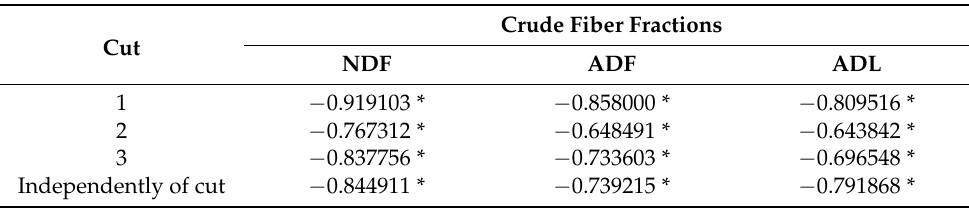
Table 6. Correlation coefficient between dry matter digestibility of Italian ryegrass and the content of crude fiber fraction depending on the